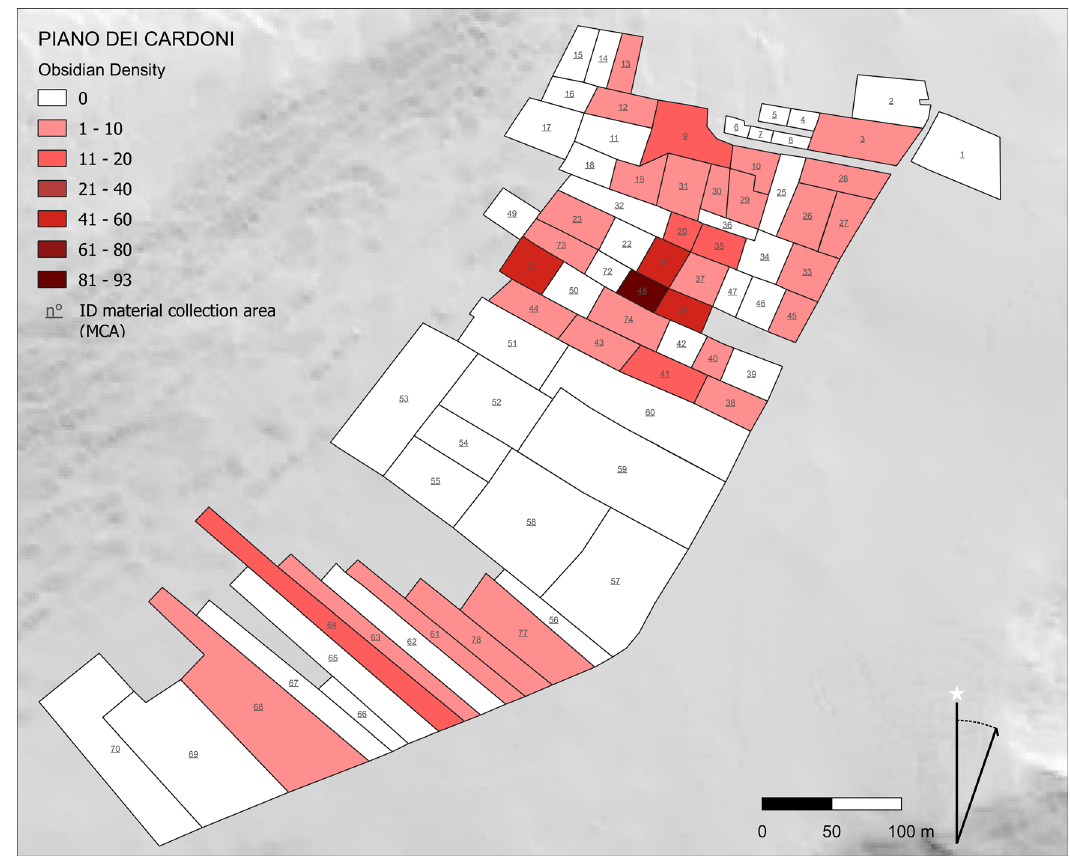
Figure 5: Surface distribution area of obsidian items collected in 2017 – 2018, from 0 ( white ) to dark red ( 93 items )